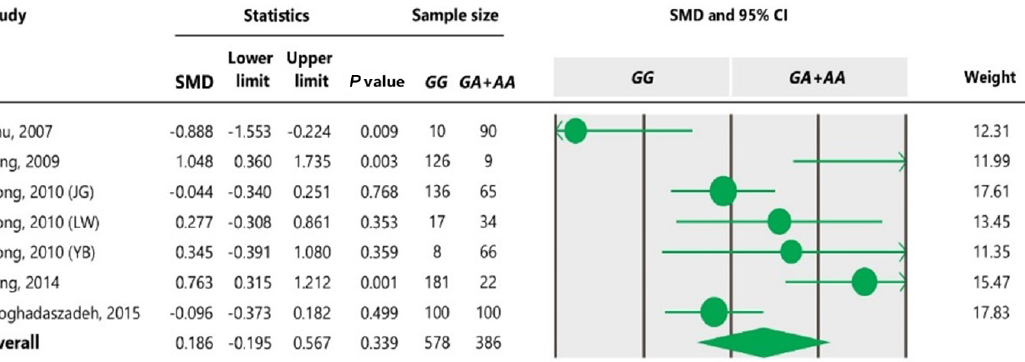
Figure 2. Funnel plots for the publication bias under the dominant model (a) , recessive model (b) , additive model (c) and co-dominant model (d) . Table 5. Forest plot of association between c.963A > G polymorphism and the litter size under the recessive model. For additional details refer to the Table 4